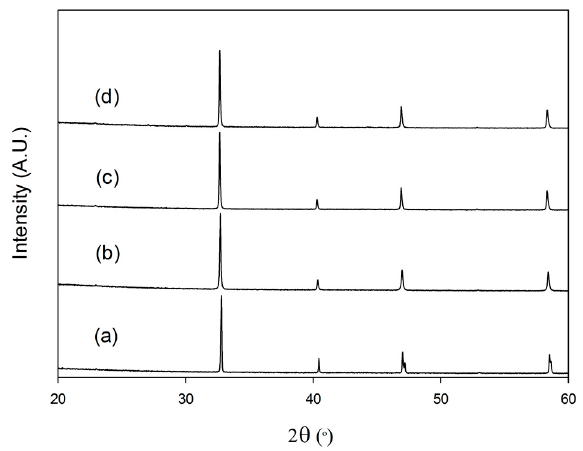
Figure 7. X-ray diffraction patterns of ( a ) SrFeO 3- δ , ( b ) SrFe 0.975 S 0.025 O 3- δ , ( c ) SrFe 0.95 S 0.05 O 3- δ , and ( d ) SrFe 0.925 S 0.075 O 3- δ after heating under O 2 .